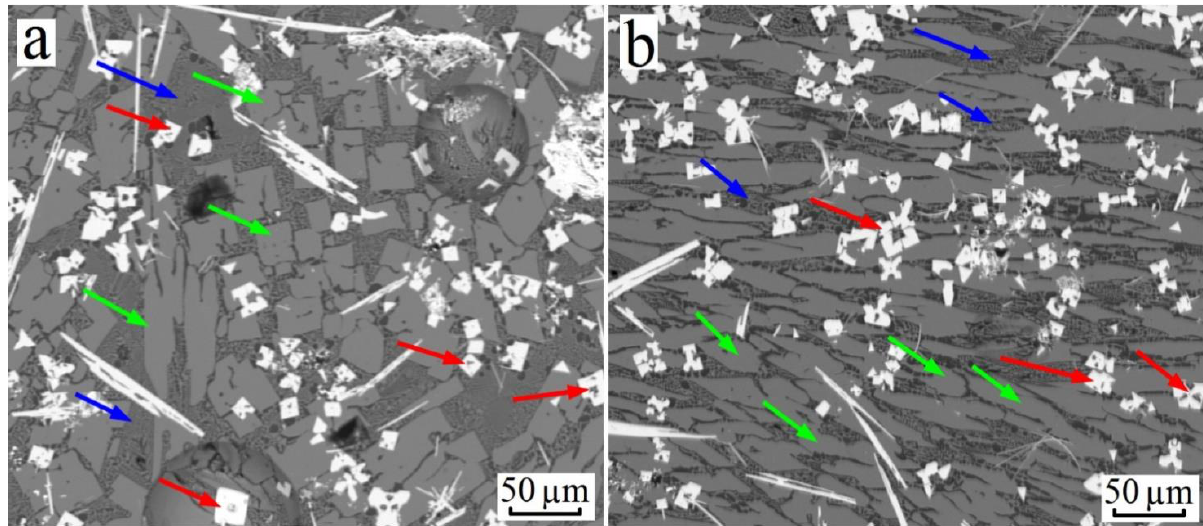
Figure 5. Distribution and forms of growth of stable and metastable aluminides in alloys: ( a ) Al– 34.09Cu–13.04Hf (H4); ( b ) Al–32.83Cu–13.04Hf (H3) (magnification × 500). The arrows point to main structural components of these alloys: the θ -phase Al 2 Cu (green arrows), the α -Al + θ eutectic (blue arrows) and L 1 2 trialuminides (red